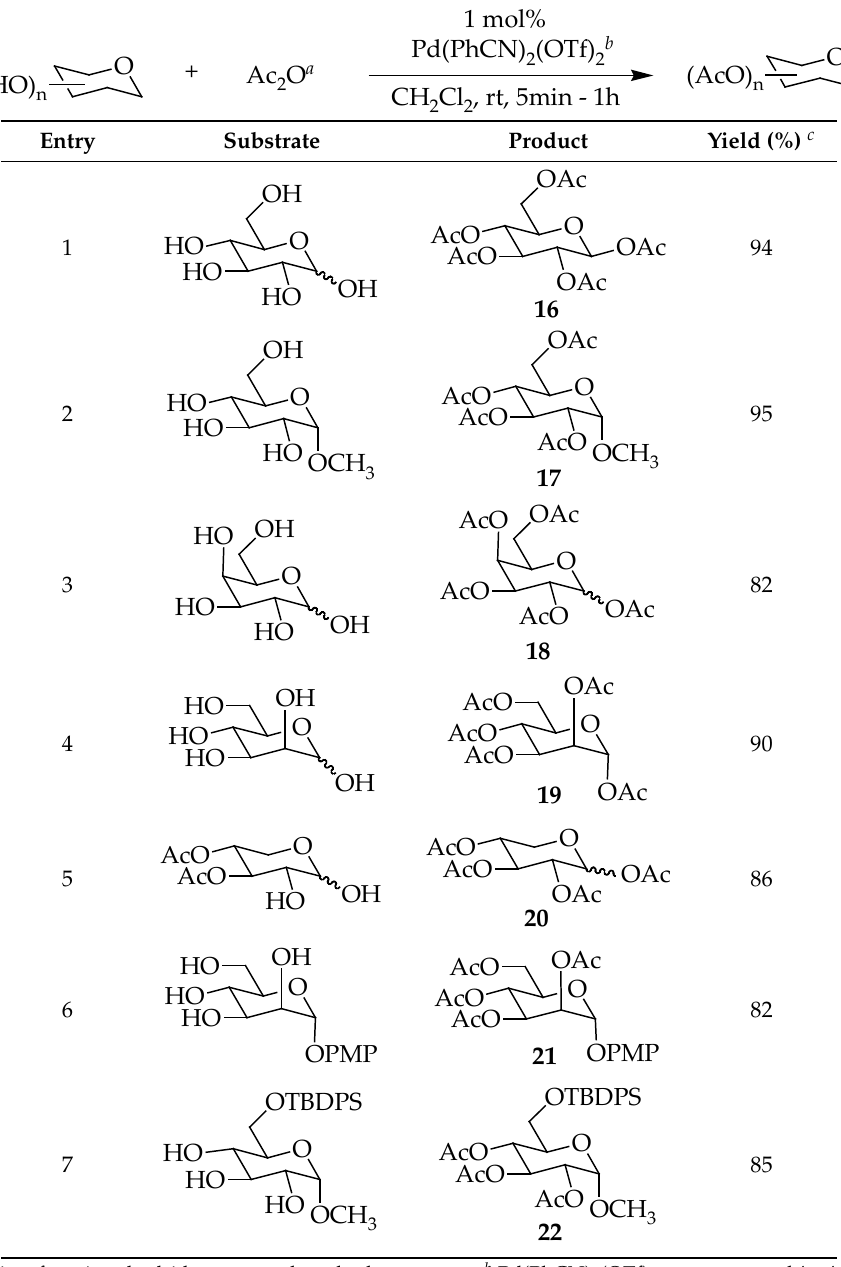
Table 4. (PhCN) 2 Pd(OTf) 2 catalyzed acetylation of carbohydrate-derived polyols. Entry